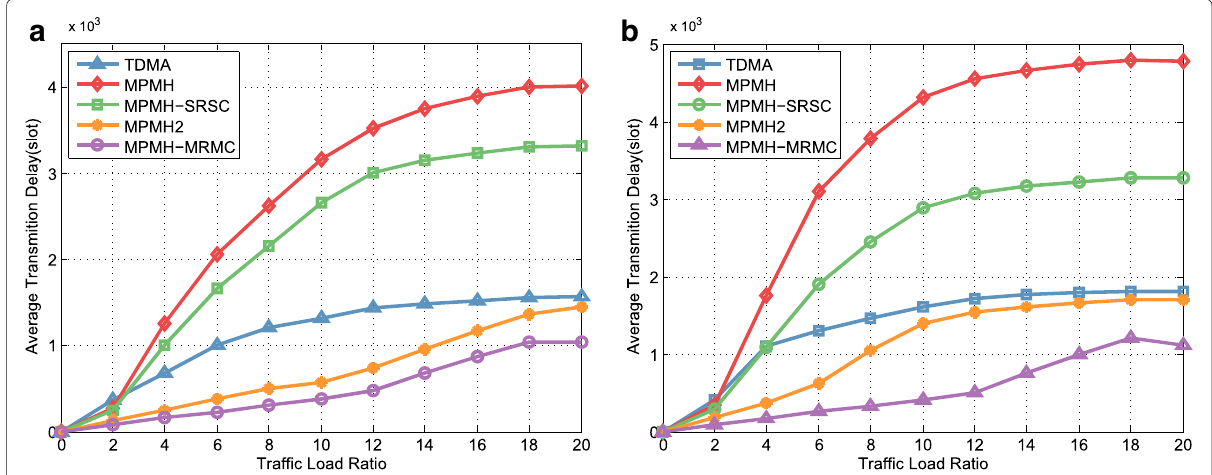
Fig. 7 Average transmission delay of the five MAC protocols under different traffic load ratios. a Uniform traffic. b Random